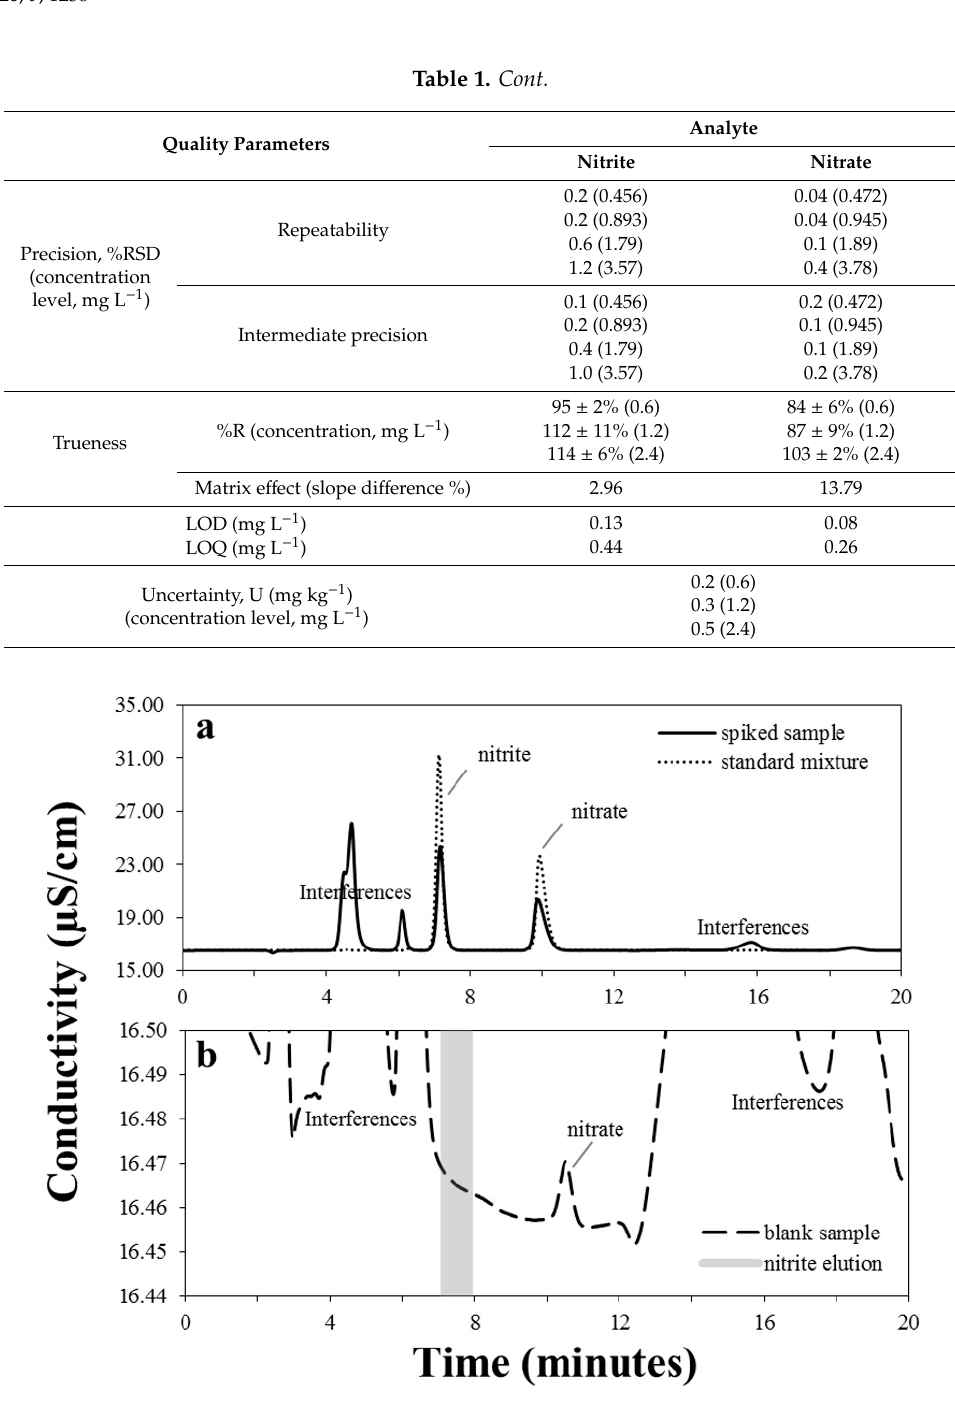
Figure 1. ( a ) Chromatographic profiles of a standard solution of nitrite 1.78 mg L − 1 and nitrate 1.89 mg L − 1 (dotted line) and a homogenized chicken sample, fortified with 35 mg kg − 1 of both nitrite and nitrate (continuous line). ( b ) Ion Chromatography-Conductivity Detection (IC-CD) profile of naturally homogenized chicken (blank), where the grey shadow corresponds to the nitrite elution window.